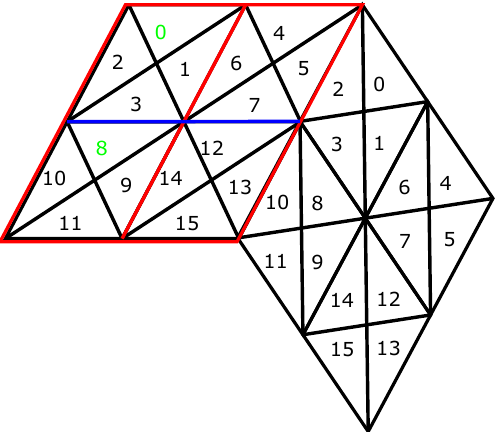
Figure 12. The rhombus highlighted in red will become a parent rhombus when we decrease subdivision levels. Rows are divided with a blue line—columns with a red line. The green indices are the start of two consecutive blocks of indices within the red rhombus. Specific indices become part of specific parents as seen in Figure 13.